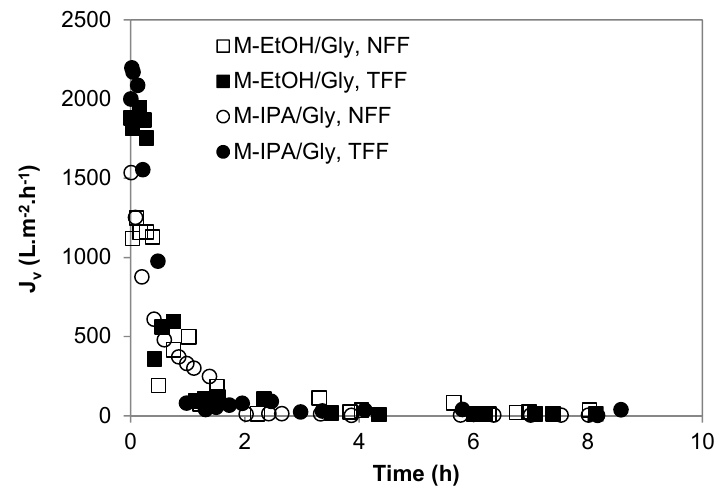
Figure 1. Representative curves of the change with time of the overall flux of M-EtOH/Gly and M-IPA/Gly membranes during BSA filtration experiments under NFF and TFF configurations at a constant working pressure of 0.2 bar, at room temperature and pH ~5. Table 1. Flux parameters (overall permeance at the steady-state (s.s.) for CWF and BSA filtration, K T , and BSA transmission ( T BSA )) in dependence the filtration configuration mode (NFF or TFF), temperature and BSA solution pH and membrane pore size (MFP, BPP and SP)) of M-EtOH/Gly and M-IPA/Gly membranes. The statistical differences of the average values of K T and T BSA were compared among the groups M-EtOH/Gly, NFF; M-EtOH/Gly, TFF; M-IPA/Gly, NFF and M-IPA/Gly, TFF. MFP, BPP and SP were compared between M-EtOH/Gly and M-IPA/Gly membranes, independently of the filtration configuration. The statistical data analysis showed no significant differences ( p < 0.05) among the samples. * indicated significant difference of BSA steady-state permeance vs CWF steady- state permeance using the t -test for unequal variances ( p < 0.05).